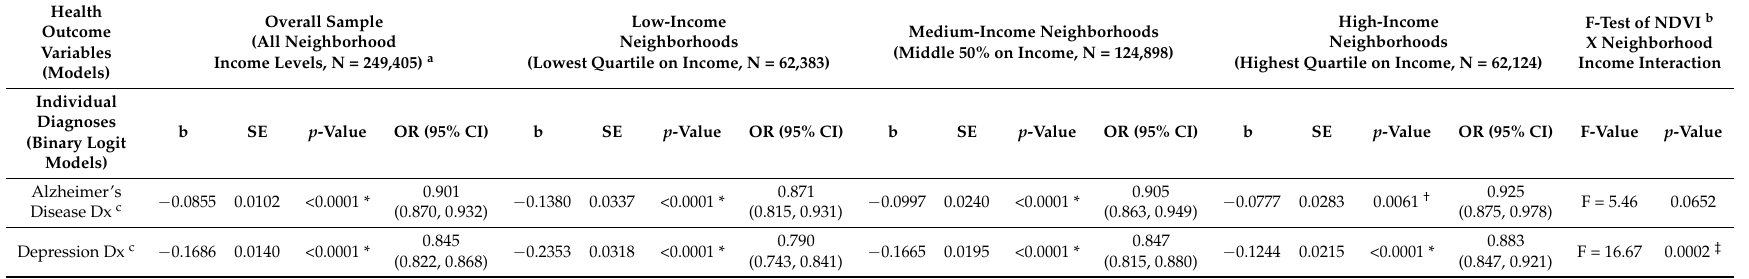
Table 2. NDVI relationships to health outcomes for the overall sample, and by neighborhood income